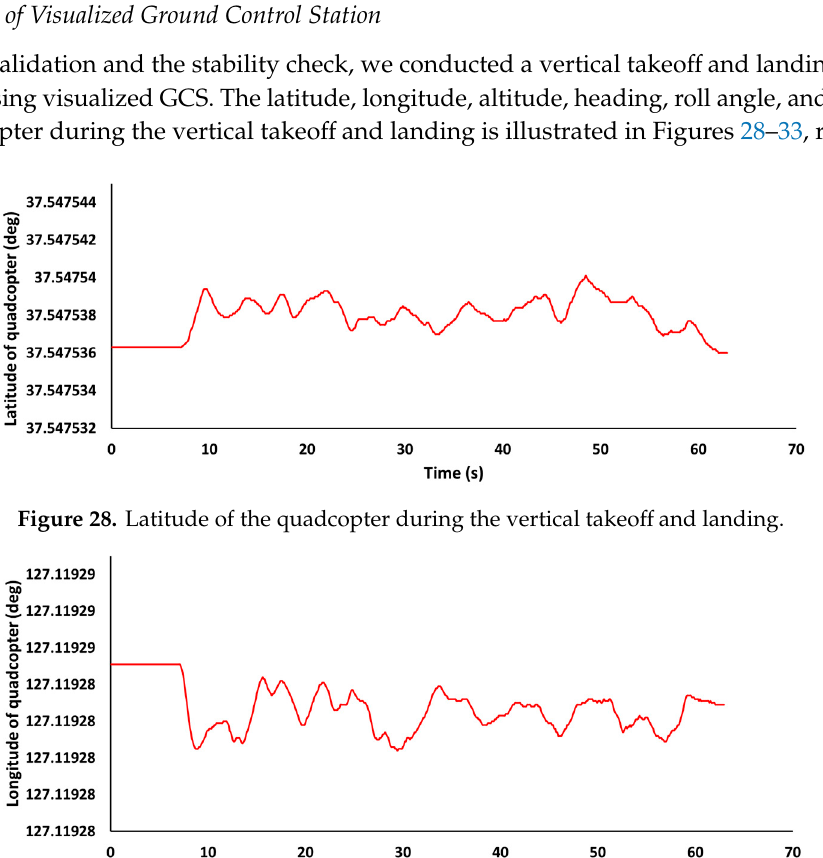
Figure 29. Longitude of the quadcopter during the vertical takeoff and landing.